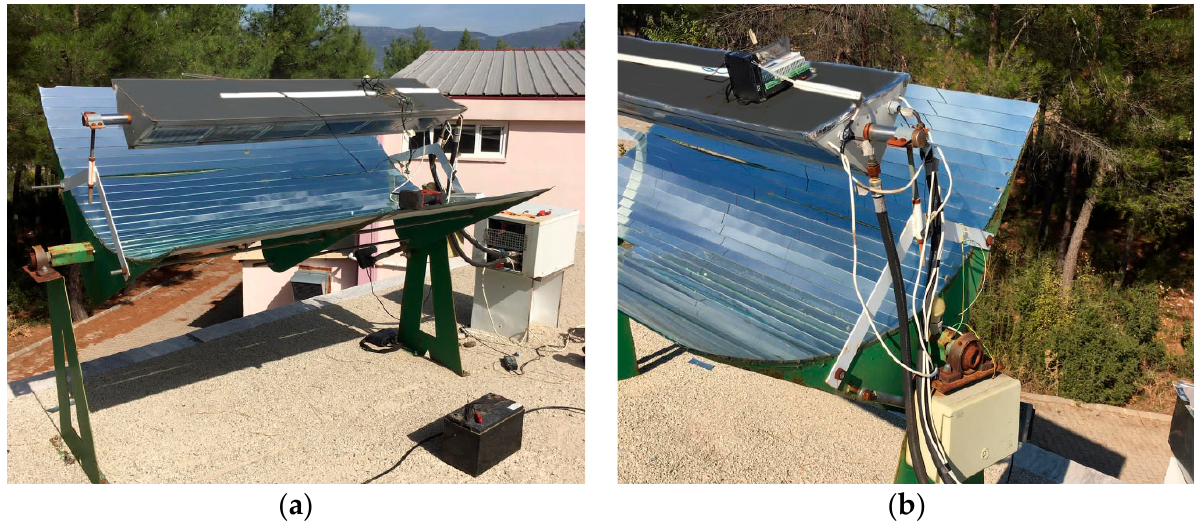
Figure 1. ( a ) A picture of the experimental setup of the CPVT system with HP, and ( b ) an image of the heat pump connected to the parabolic triangular trough of the PV collector. Table 1. Technical properties of the bifacial CPVT system with HP. Components